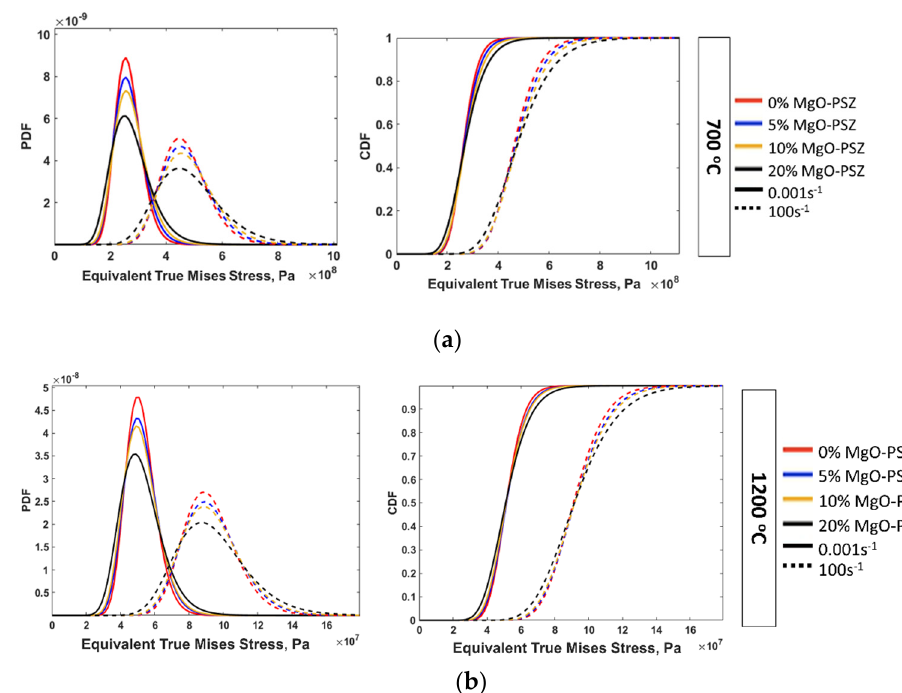
Figure 10. The PDF and CDF for austenite grains against true stress at 0.1 global strain at ( a ) 700 °C and ( b ) 1200 °C.